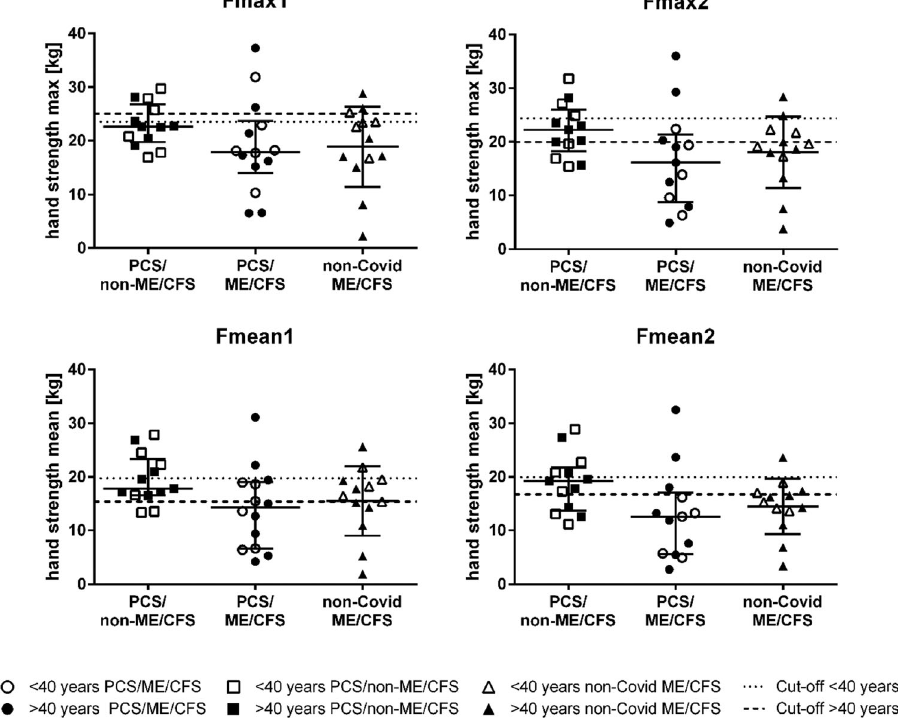
Fig.3|Handgripstrength(HGS). HGShandgripstrength;PCS/non-ME/CFSpost- COVID-19 syndrome/non-myalgic encephalomyelitis/chronic fatigue syndrome; PCS/ME/CFS post-COVID-19 syndrome/myalgic encephalomyelitis/chronic fatigue syndrome; non-COVID ME/CFS non-COVID-19 myalgic encephalomyelitis/chronic fatigue syndrome. HGS was assessed in PCS cohorts (PCS/non-ME/CFS n =13,PCS/ ME/CFS n =14 for Fmax1 and Fmean1, n =13 for Fmax2 and Fmean2) and non-